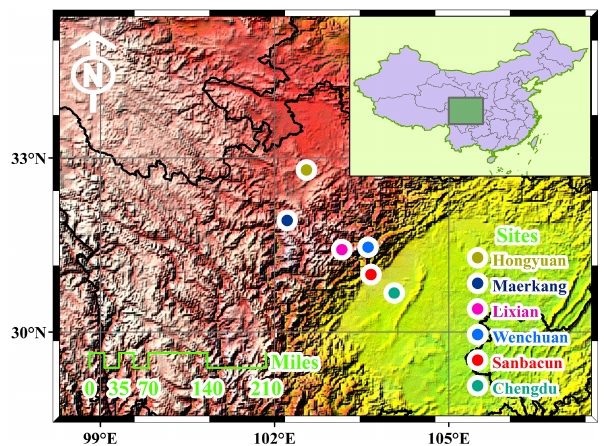
Figure 1. Geographic location of the six in situ measurement sites (Chengdu, Sanbacun, Wenchuan, Lixian, Maerkang and Hongyuan) along the ESTP. The map is a pure reproduction of Google Maps with added marks for our study locations. Copyright © Google Maps. Publisher’s note: Please note that the above figure contains disputed territories. Table 1. Summary of the measurement sites (name, location and altitude). Latitude Longitude Altitude Name (degree) (degree)